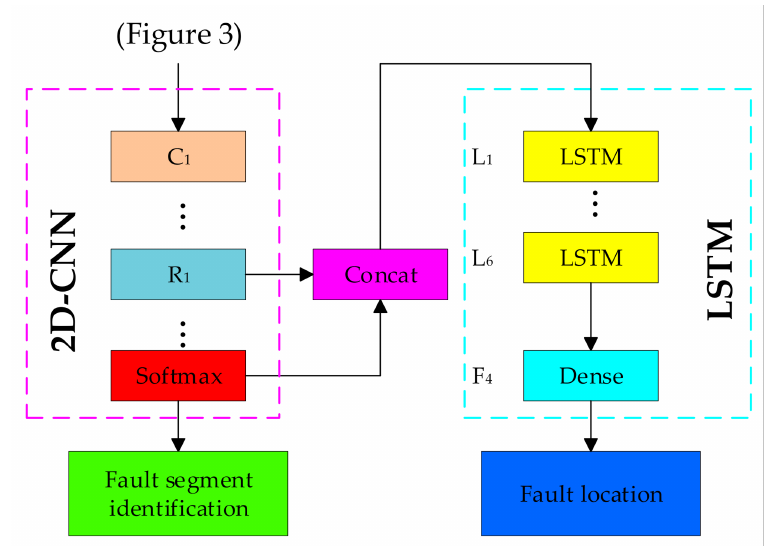
Figure 8. CNN-LSTM hybrid